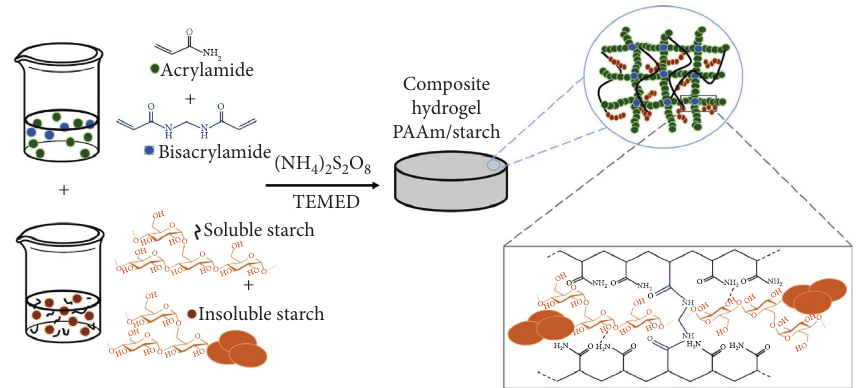
Figure 1: PAAm/starch composite hydrogel preparation